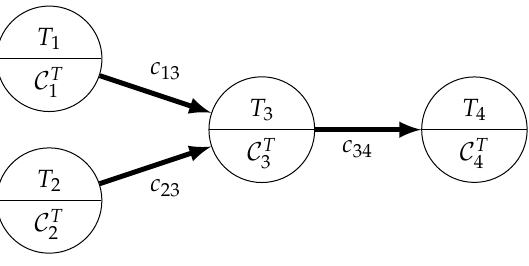
Figure 2. Basic task graph